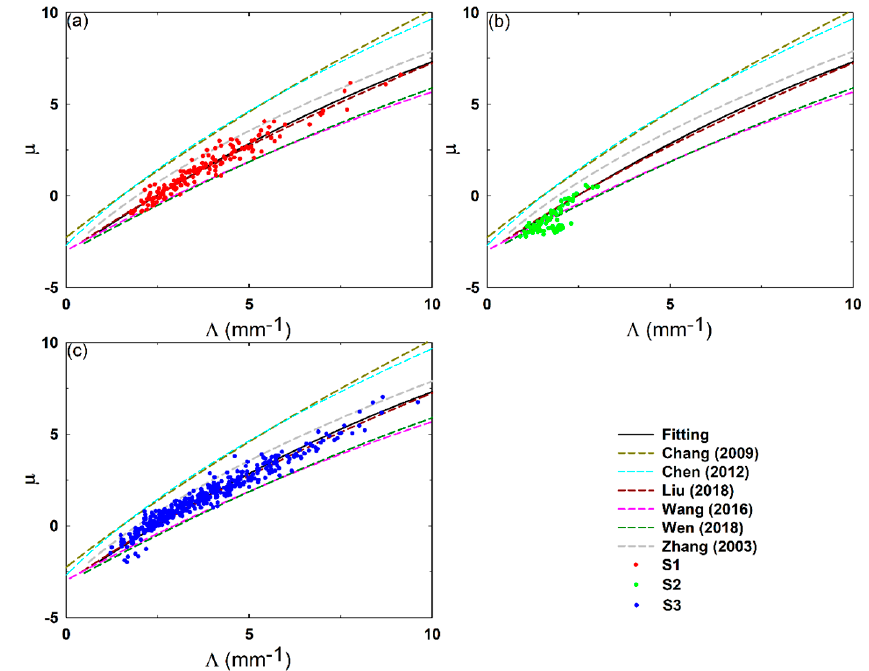
Figure 10. Scatterplots of the μ – Λ relationships during ( a ) S1, ( b ) S2, and ( c ) S3. S1, S2, and S3 are shown as red dots, green dots, and blue dots, respectively. The black lines denote the fitting curves of the filtered samples. In addition, the µ – Λ relationships from Chang (2009), Chen (2012), Liu (2018), Wang (2016), Wen (2018), and Zhang (2003) are provided. S1: the outer rainband before landfall, S2: the inner core, S3: the outer rainband after landfall.